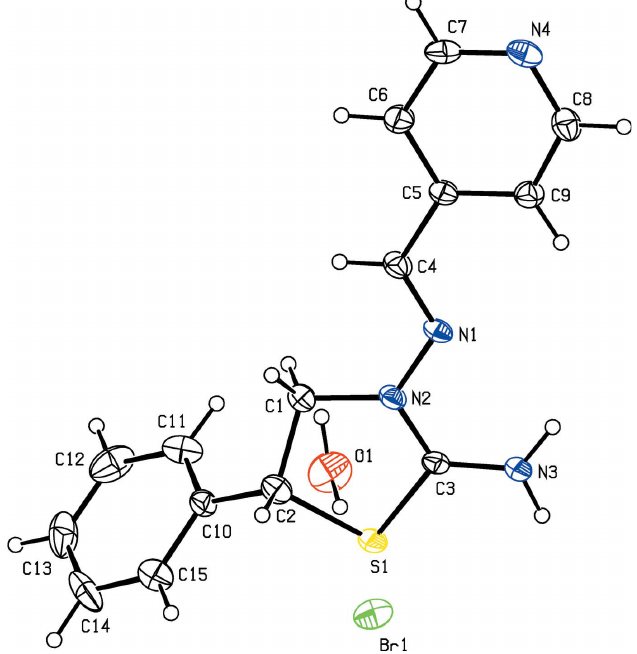
Figure 1 The molecular structure of the title salt. Displacement ellipsoids are drawn at the 30% probability level. H atoms are shown as spheres of arbitrary radius.